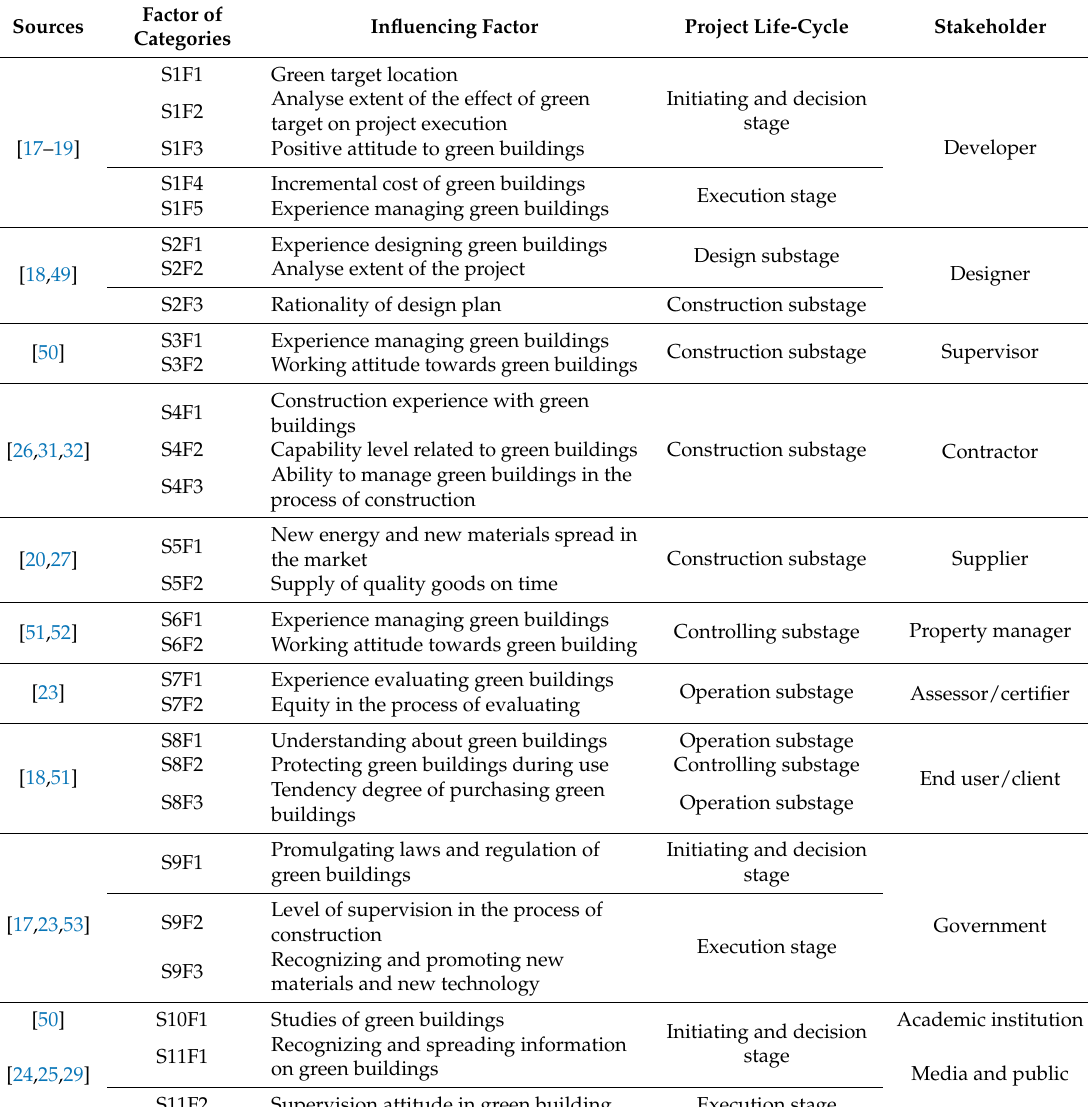
Table 2. The stakeholders and related influencing